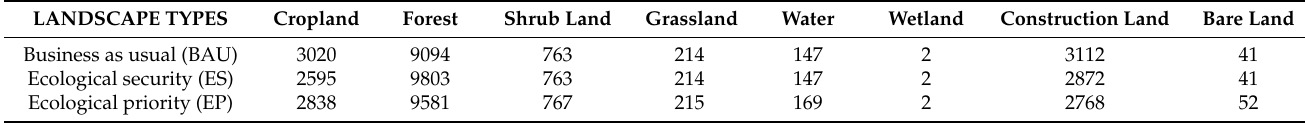
Table 4. The area of landscape types in 2031 under different scenarios (km 2